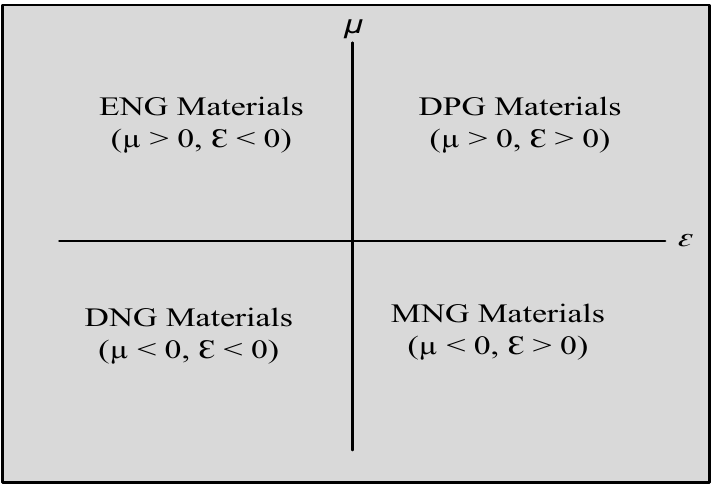
Figure 1. Classification of metamaterial by sign of µ and ε